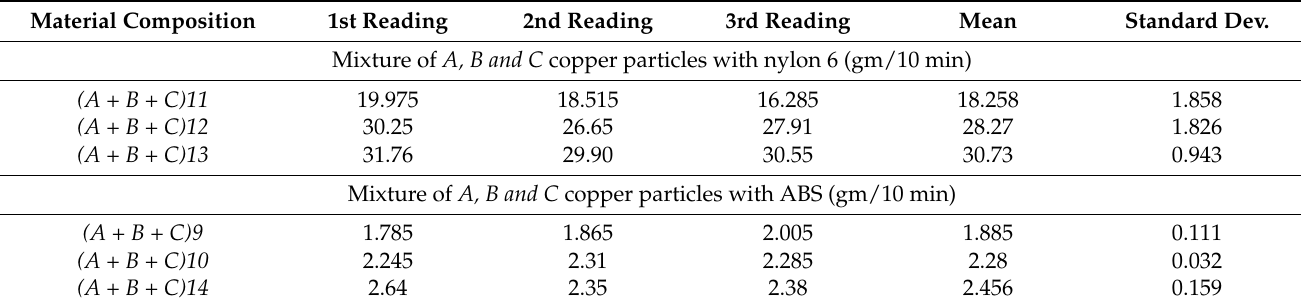
Table 6. MFI of ABS and nylon 6 with triple particle size